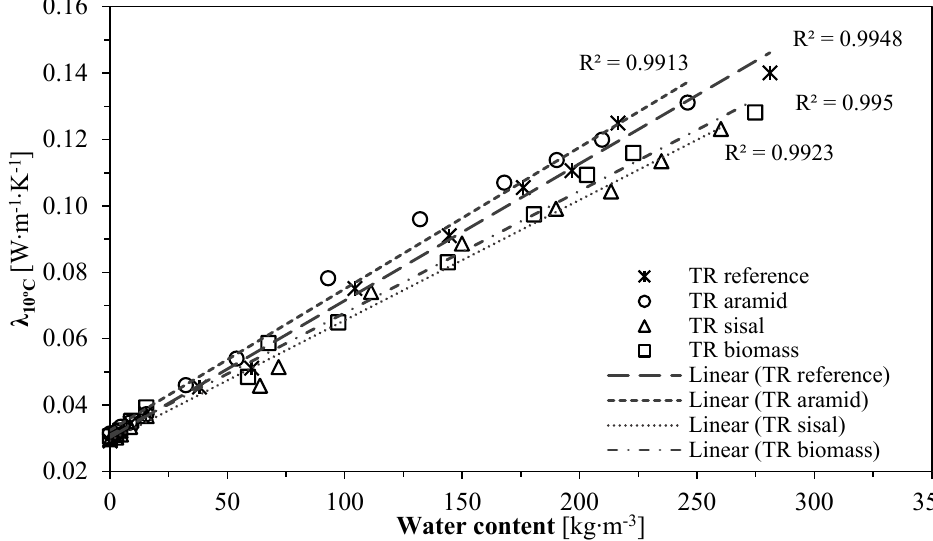
Figure 4. Thermal conductivity as a function of water content, at 10 °C.